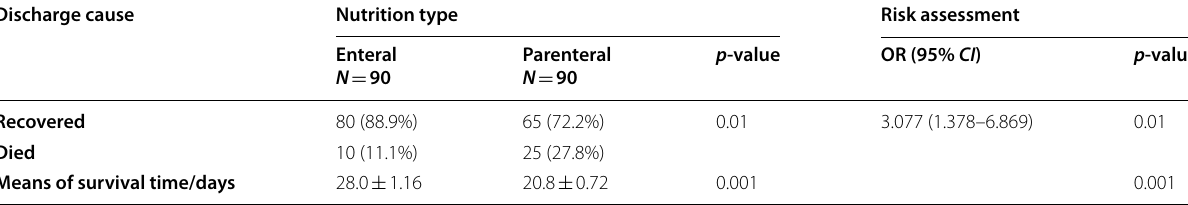
Discharge causes of data are represented as frequency and percent; the data were analyzed by Χ 2 test. CI Confidence interval, the data were analyzed by Kaplan– Meier test